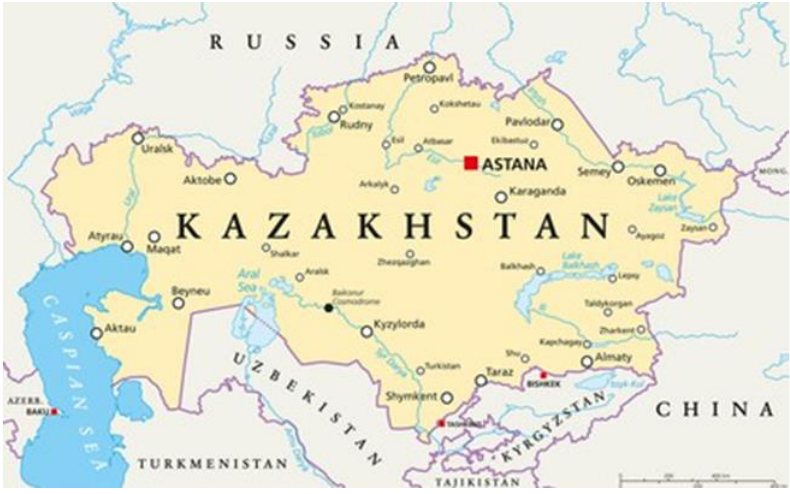
Figure 1. Kazakhstan land boundaries